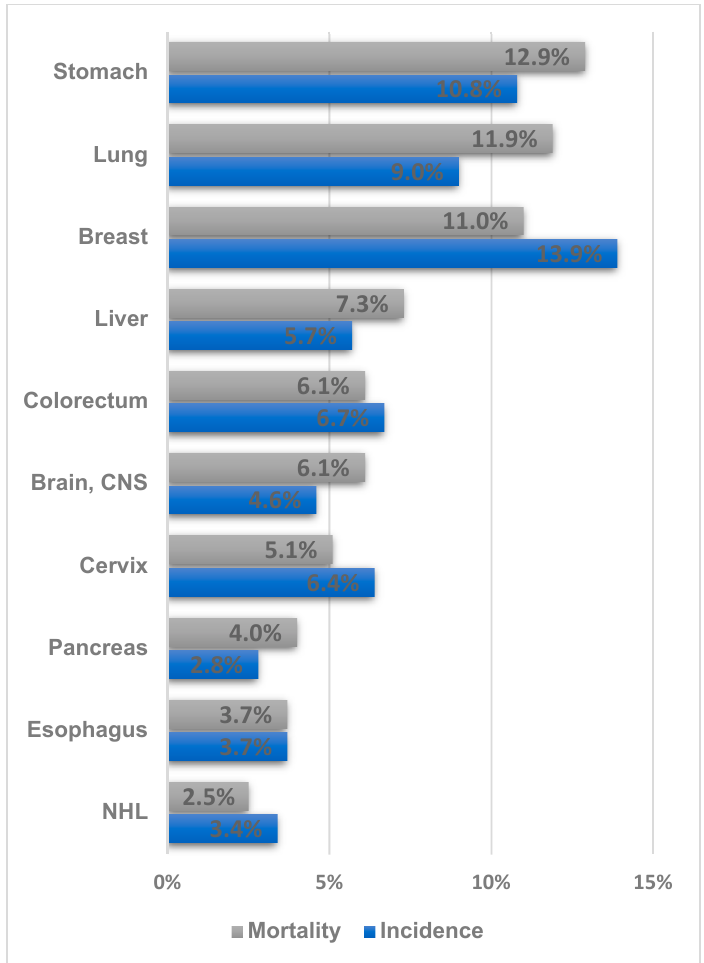
Figure 2. Ranking of the frequency and mortality of the major cancer types in Uzbekistan (Data source: Cancer country profile, WHO, 2020; Global Health Observatory, WHO, 2016. Figure drawn by authors) [12,13].